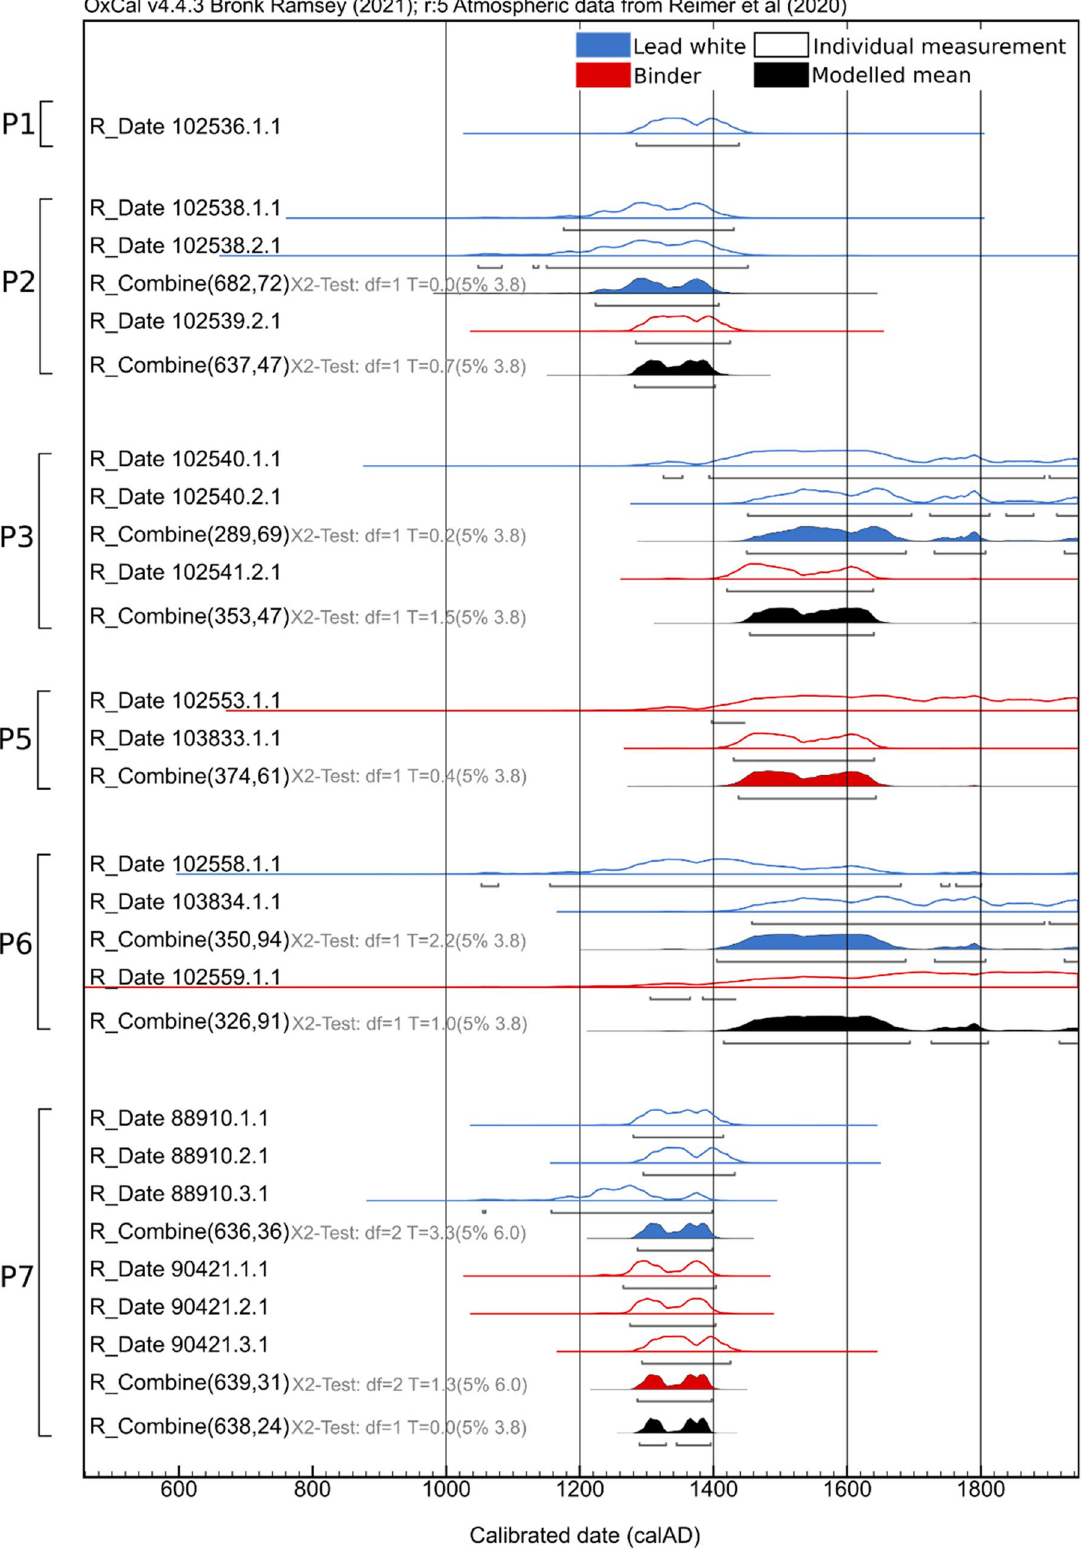
Figure 1. Calibrated 14 C ages for the samples of Pero’s workshop. The simple radiocarbon calibration of the 14 C ages of lead white (blue) and binder (red) are displayed as outlines while the solid distributions represent their mean value using the combine function in